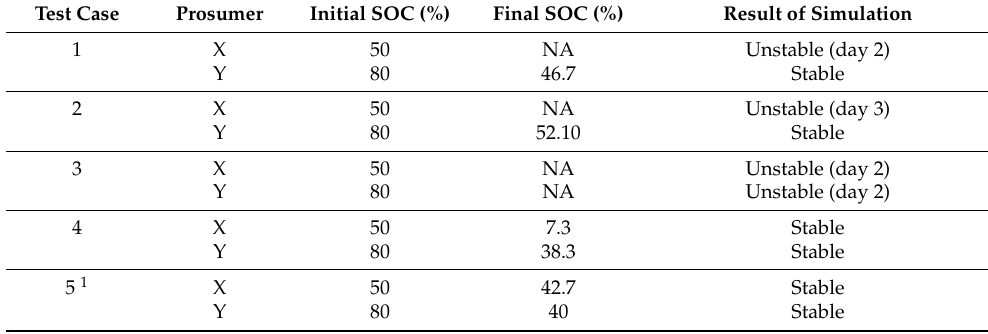
Table 5. Summary of